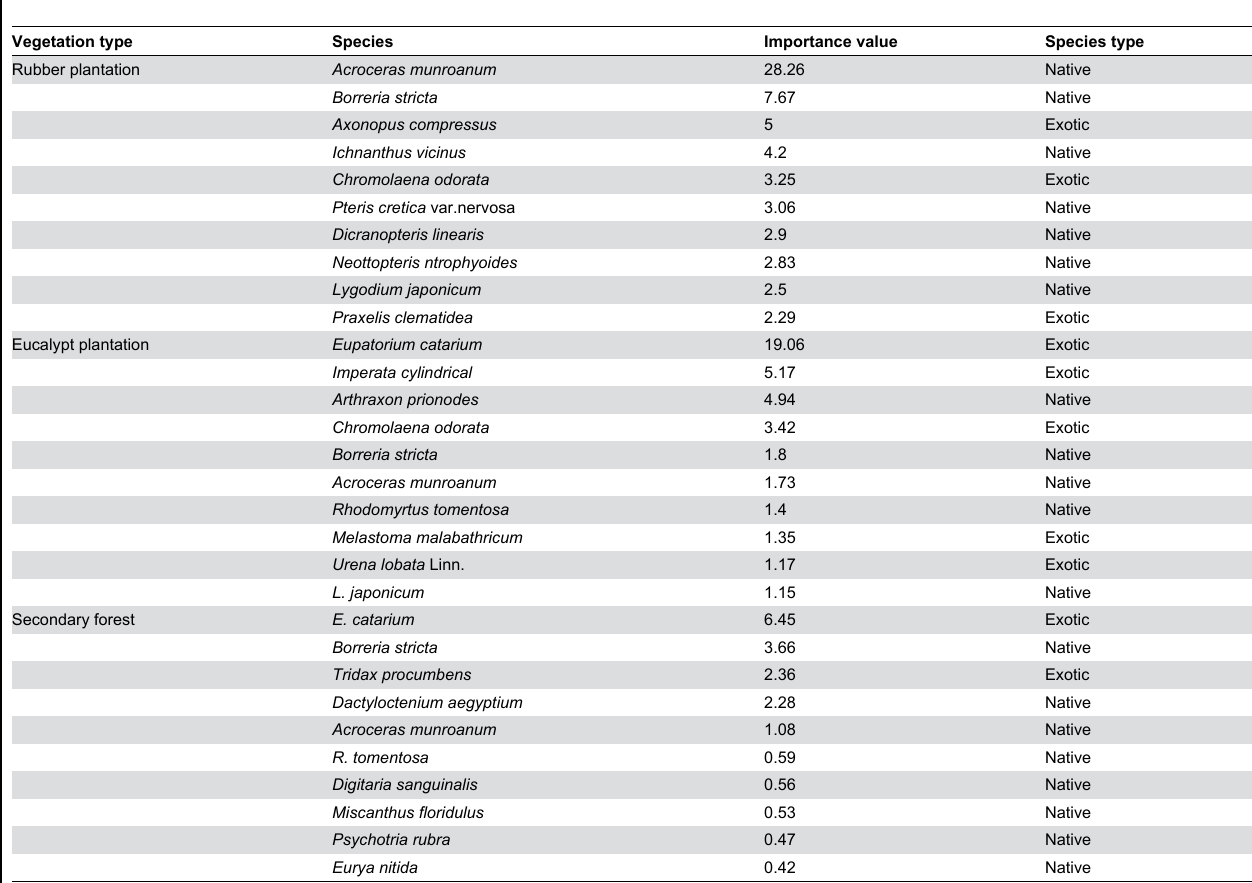
Table 1. Top 10 understory species of importance value rank for each of the three forest types.